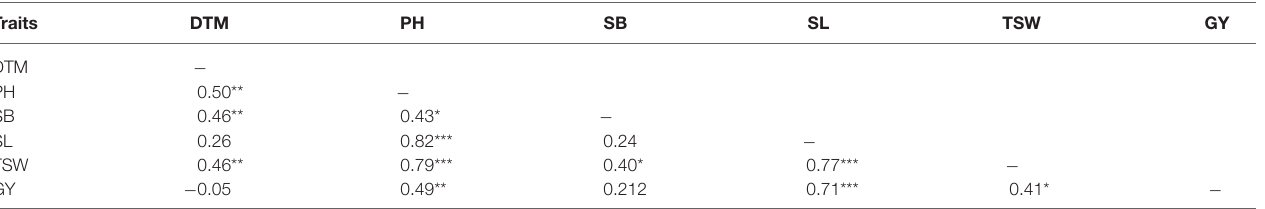
TABLE 5 | Pairwise correlation coefficients among agronomic traits measured in three EMS-treated populations of wheat and control during four generations. Traits DTM PH SB SL